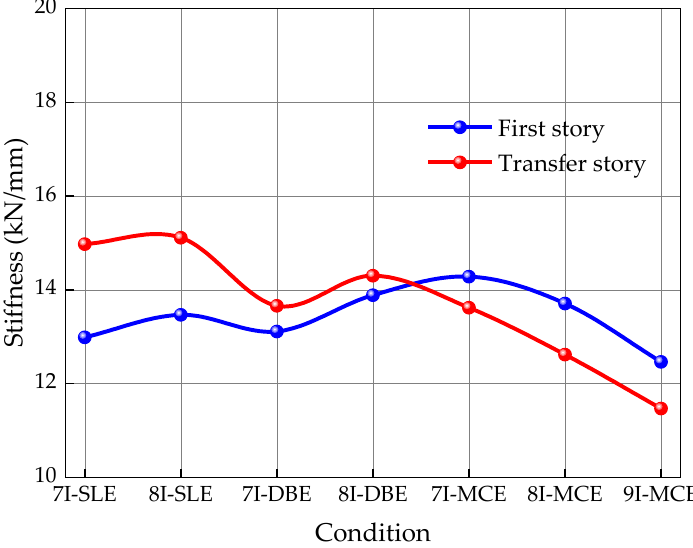
Figure 26. Secant stiffness curve.